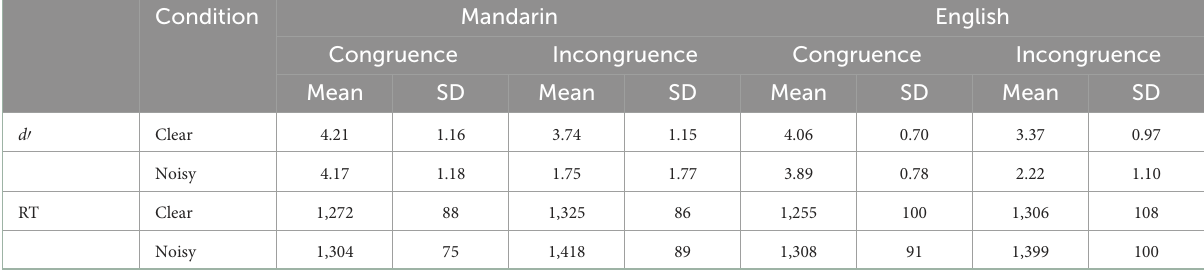
TABLE 3 The mean d’ and RT (in ms) of the vowel task for Mandarin ( N = 21) and English speakers ( N = 32).